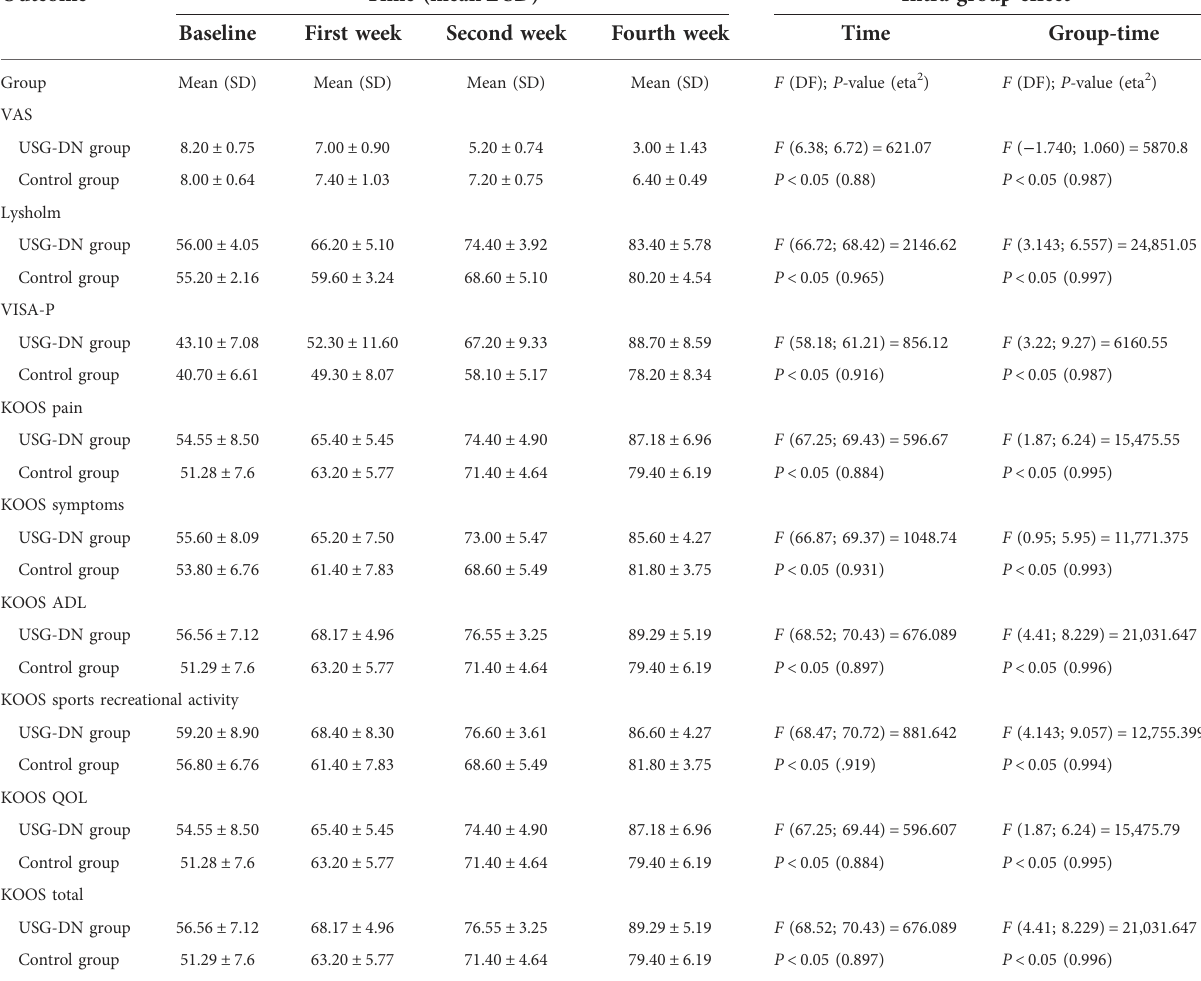
TABLE 3 Outcome data for VAS, VISA-P, Lysholm and KOOS